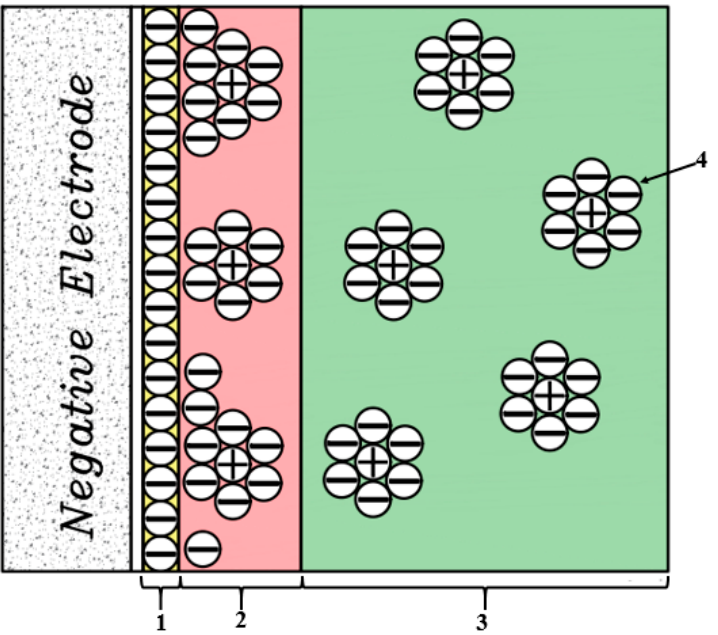
Figure 15. Stern extended model (Grahame model), 1: Inner Helmholtz layer, 2: Outer Helmholtz layers, 3: Diffusion layers, 4: Coated solvent ions.